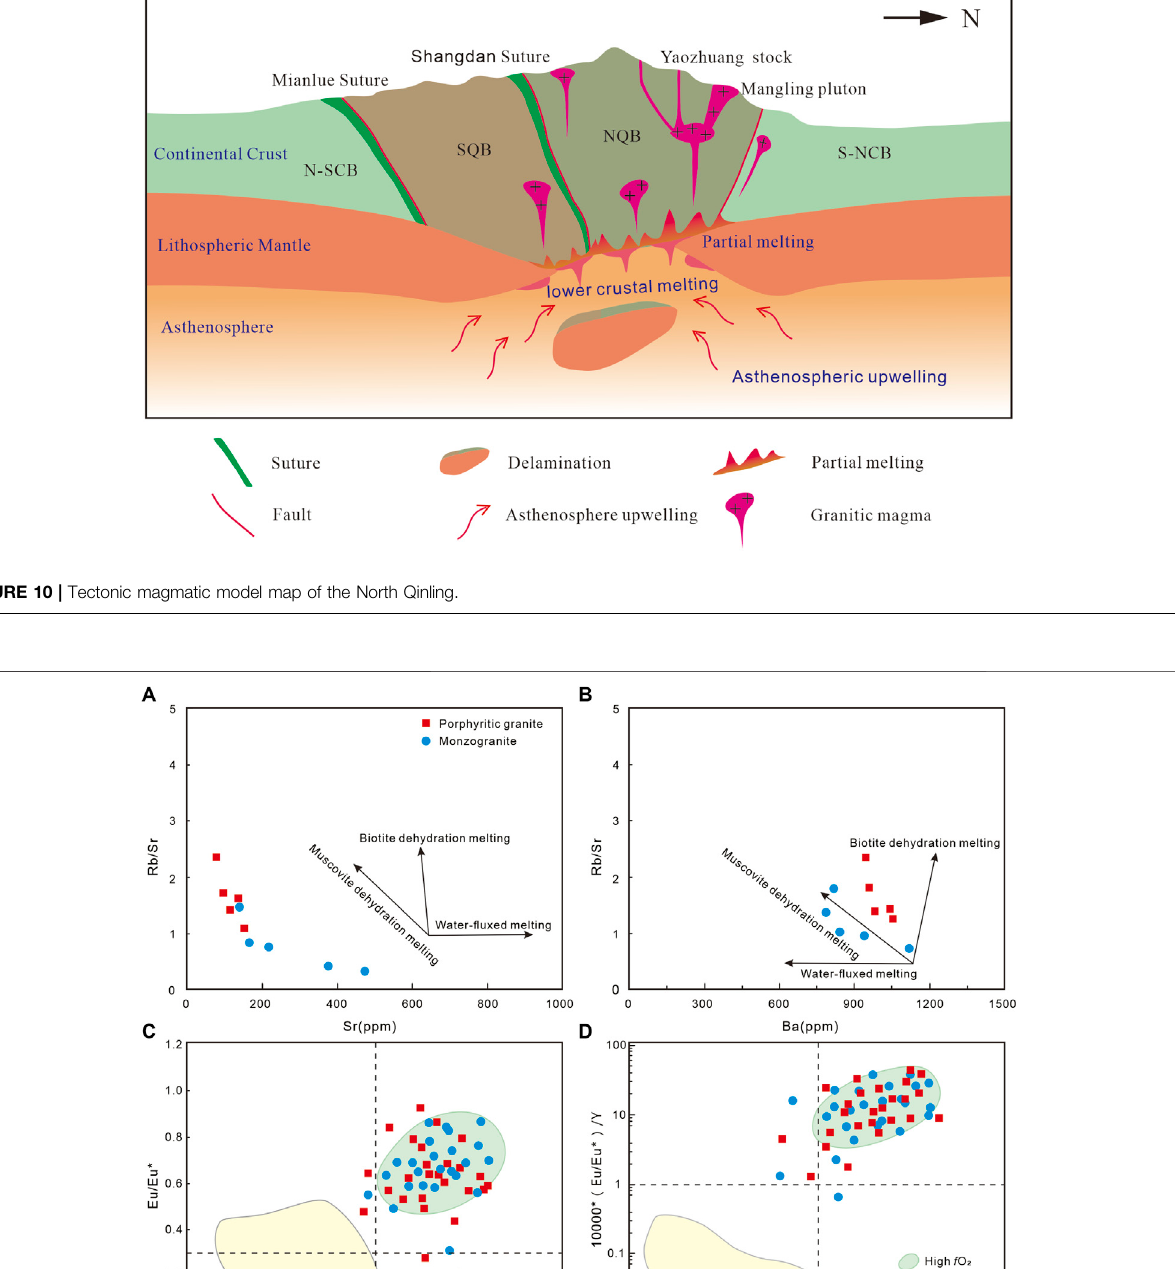
Frontiers in Earth Science |